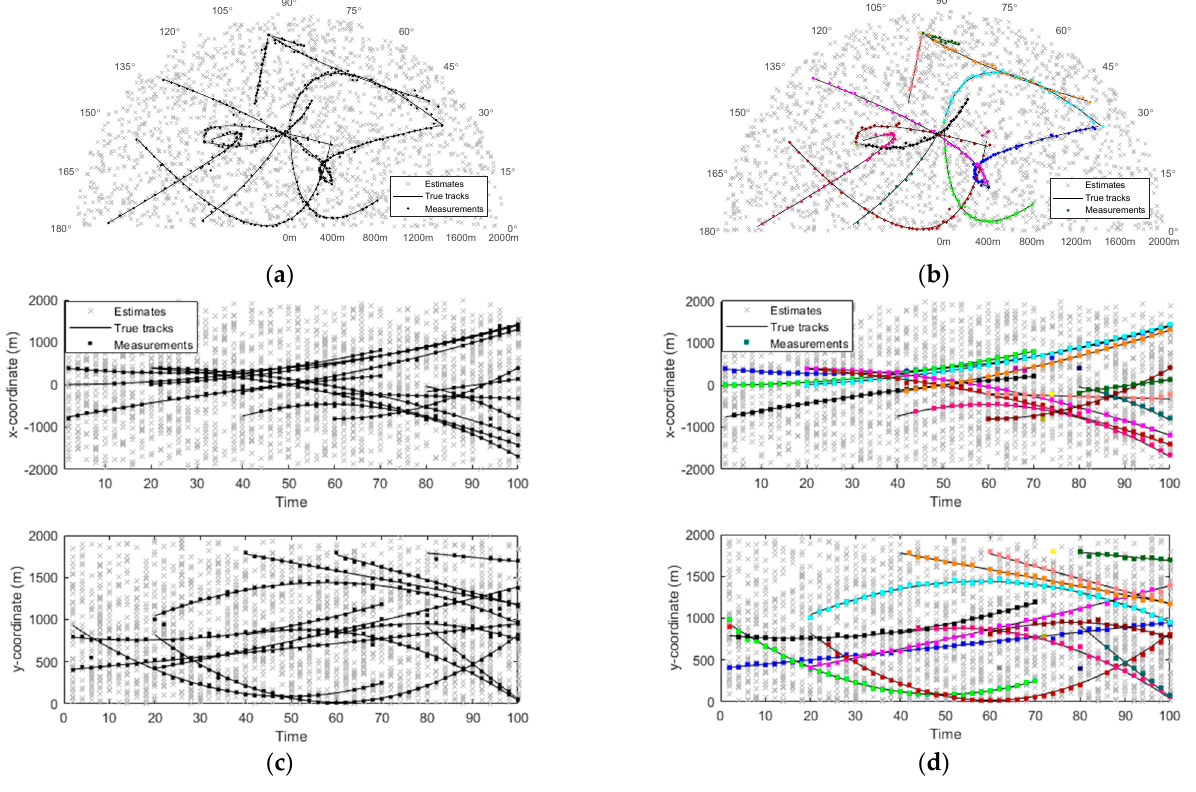
Figure 13. The estimations of the multi-target trajectories and the actual measurements in example 2 (CA motion model) for a sample run. ( a ) The actual measurements, actual trajectories and estimated trajectories obtained after filtering by the SM-GM-PHD filter for T s = 2 s ( T i = 4 ms, λ = 52, p D , k = 0.96). ( b ) The actual measurements, actual trajectories and estimated trajectories obtained after filtering by the SM-LGM-PHD filter for T s = 2 s, and the different trajectories are denoted by different color dots. ( c ) The actual measurements, actual trajectories and estimated trajectories obtained after filtering by the SM-GM-PHD filter in x and y coordinates for T s = 2 s. ( d ) The actual measurements, actual trajectories and estimated trajectories obtained after filtering by the SM-LGM-PHD filter in x and y coordinates for T s = 2 s.